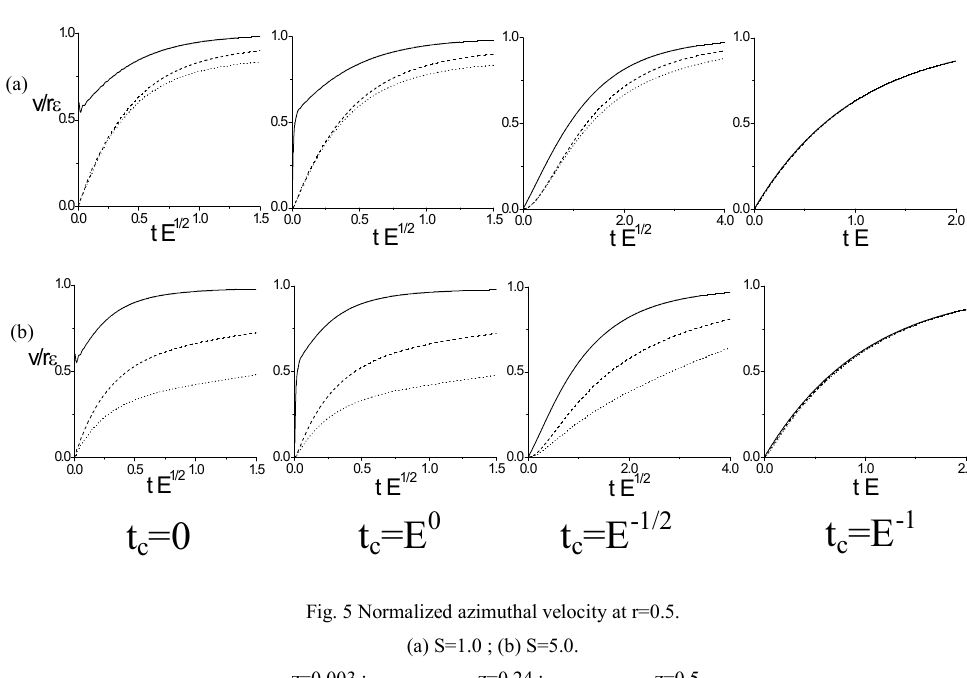
Fig. 5 Normalized azimuthal velocity at